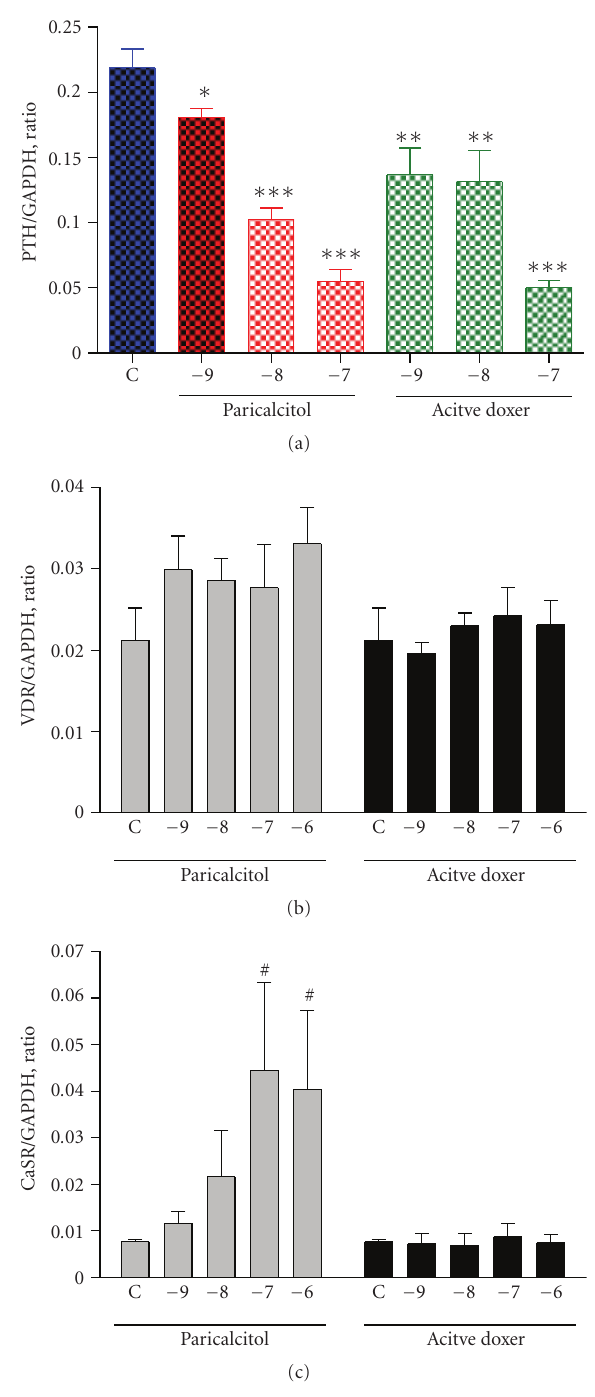
Figure 5: E ff ect of paricalcitol and active doxercalciferol on the expression of PTH, VDR, and CaSR mRNA in pig parathyroid cells. Cells were treated with paricalcitol and active doxercalciferol at indicated concentrations (in log M ) for 24 hours. Samples were processed and real-time RT-PCR performed. The mRNA expression level was normalized to the GAPDH mRNA level. C: control (no drug treatment); doxer: doxercalciferol. Values shown are mean ± the standard deviation ( n = 4). One way ANOVA Dunnett test with 95% confidence intervals of di ff erence was performed for statistical comparisons. ∗ P < . 05, ∗∗ P < . 01, ∗∗∗ P < . 001 versus Control (C, no drug treatment). # P < . 05 versus Control (C).